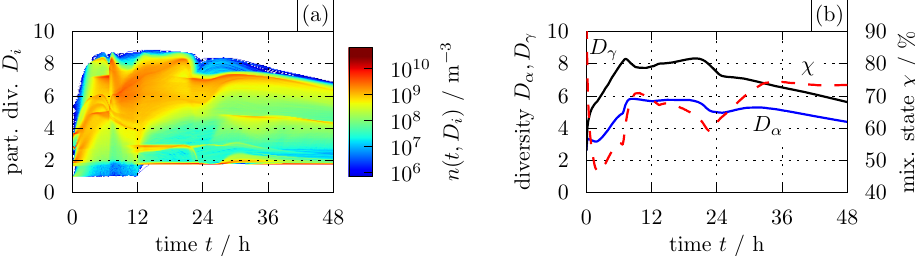
Fig. 8. Diversity and mixing state evolution for all particles in the urban plume case. (a) Distribution of per-particle diversity D i as a function of time. (b) Time series of average particle diversity D α , population diversity D γ , and the mixing state index χ .